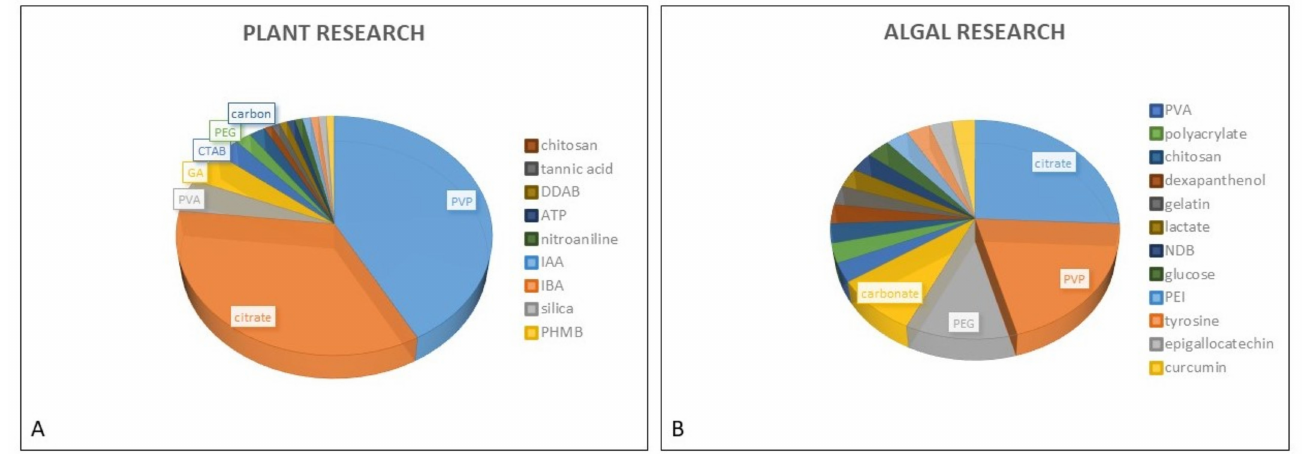
Figure 1. Proportional representation of coatings used for AgNP stabilization in plant ( A ) and algal ( B )